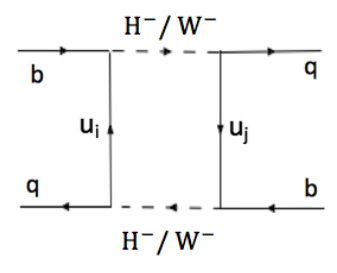
Figure 1 . The diagrams that contribute to the B